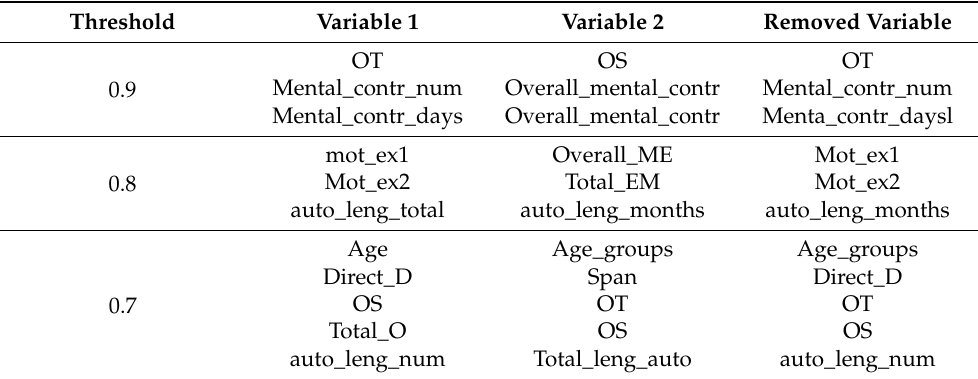
Table 5. Removal of variables based on the Pearson correlation